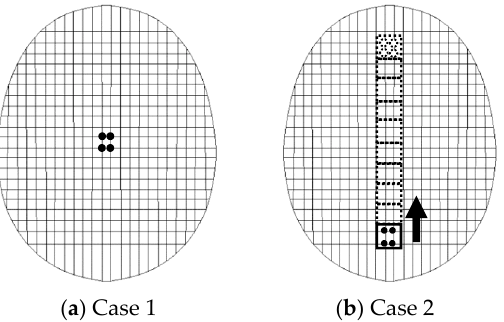
Figure 9. Out-of-plane stiffness of the string planes of the three racquets.